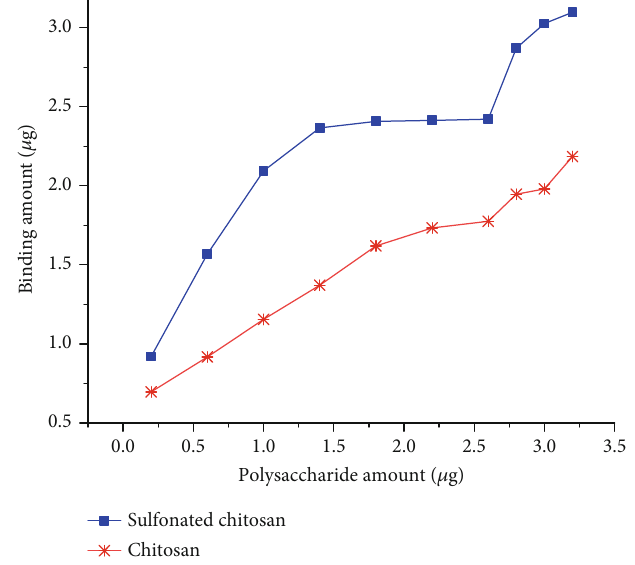
Figure 7: The binding capacity of BSA on sulfonated chitosan and